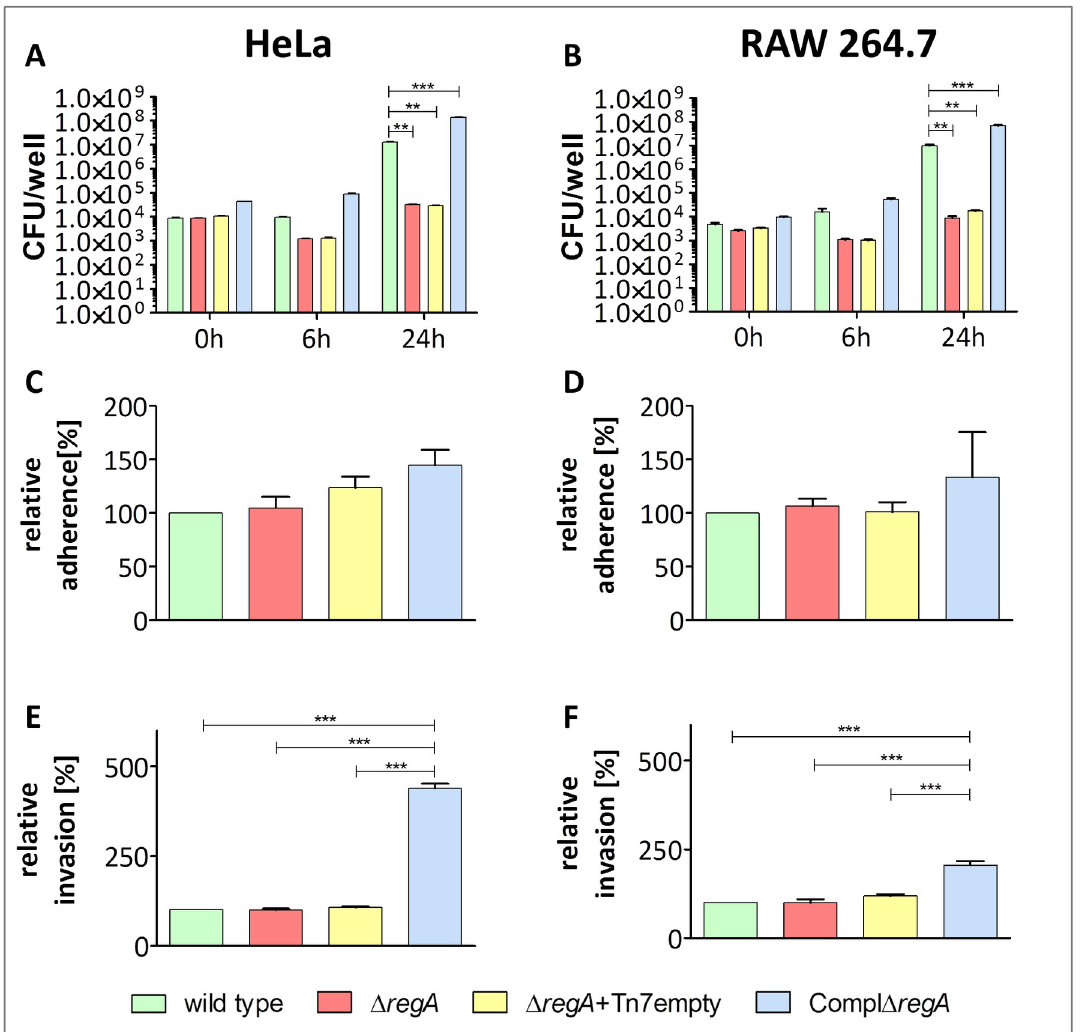
Fig 2. Replication (A, B), relative adherence (C, D) and relative invasion (E, F) of B . pseudomallei strains in HeLa- T cells and RAW264.7 macrophages. Wild type strain, Δ regA mutant, Δ regA +Tn7empty (mutant with an empty pUC18T-mini-Tn7-Km-FRT plasmid) and the complemented mutant Compl Δ regA were cultivated aerobically on blood agar for 16 hours at 37˚C. Then, cells were diluted in PBS and used at MOI 10 with HeLa- T cells (A, C, E) and MOI 5 with RAW264.7 macrophages (B, D, F) for infections. A and B (intracellular replication): At indicated time points (0, 6, 24 hours), the infected Hela- T and RAW264.7 cells were lysed and dilutions were plated on LB agar plates. After 48 h of growth at 37˚C colonies of B . pseudomallei on the plates were counted and CFU/well were calculated. Shown are mean values of three independent experiments. Error bars indicate standard error of the mean (SEM). C, D, E and F (relative adherence and invasion): For determination of adhesion, numbers of adherent bacteria were calculated at 30 minutes post-infection. For determination of invasion, numbers of invasive bacteria were calculated at 30 minutes post-infection plus 30 minutes after antibiotic protection assay. The percentage of adhesion and invasion represented the number of intracellular bacteria relative to their inoculums compared to the wild type. Shown are mean values of three independent experiments. Error bars indicate standard error of the mean (SEM). Statistical analyses were performed by using ONE- way- ANOVA followed by Bonferroni post- hoc test ( � p < 0.05; �� p < 0.01, ��� p <